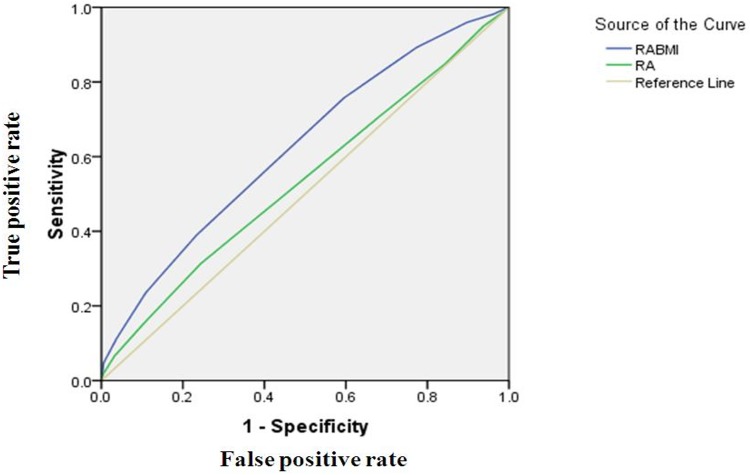
ROC plot for 9 variants alone (AUC -0.536) and 9 variants plus BMI (AUC- 0.624).